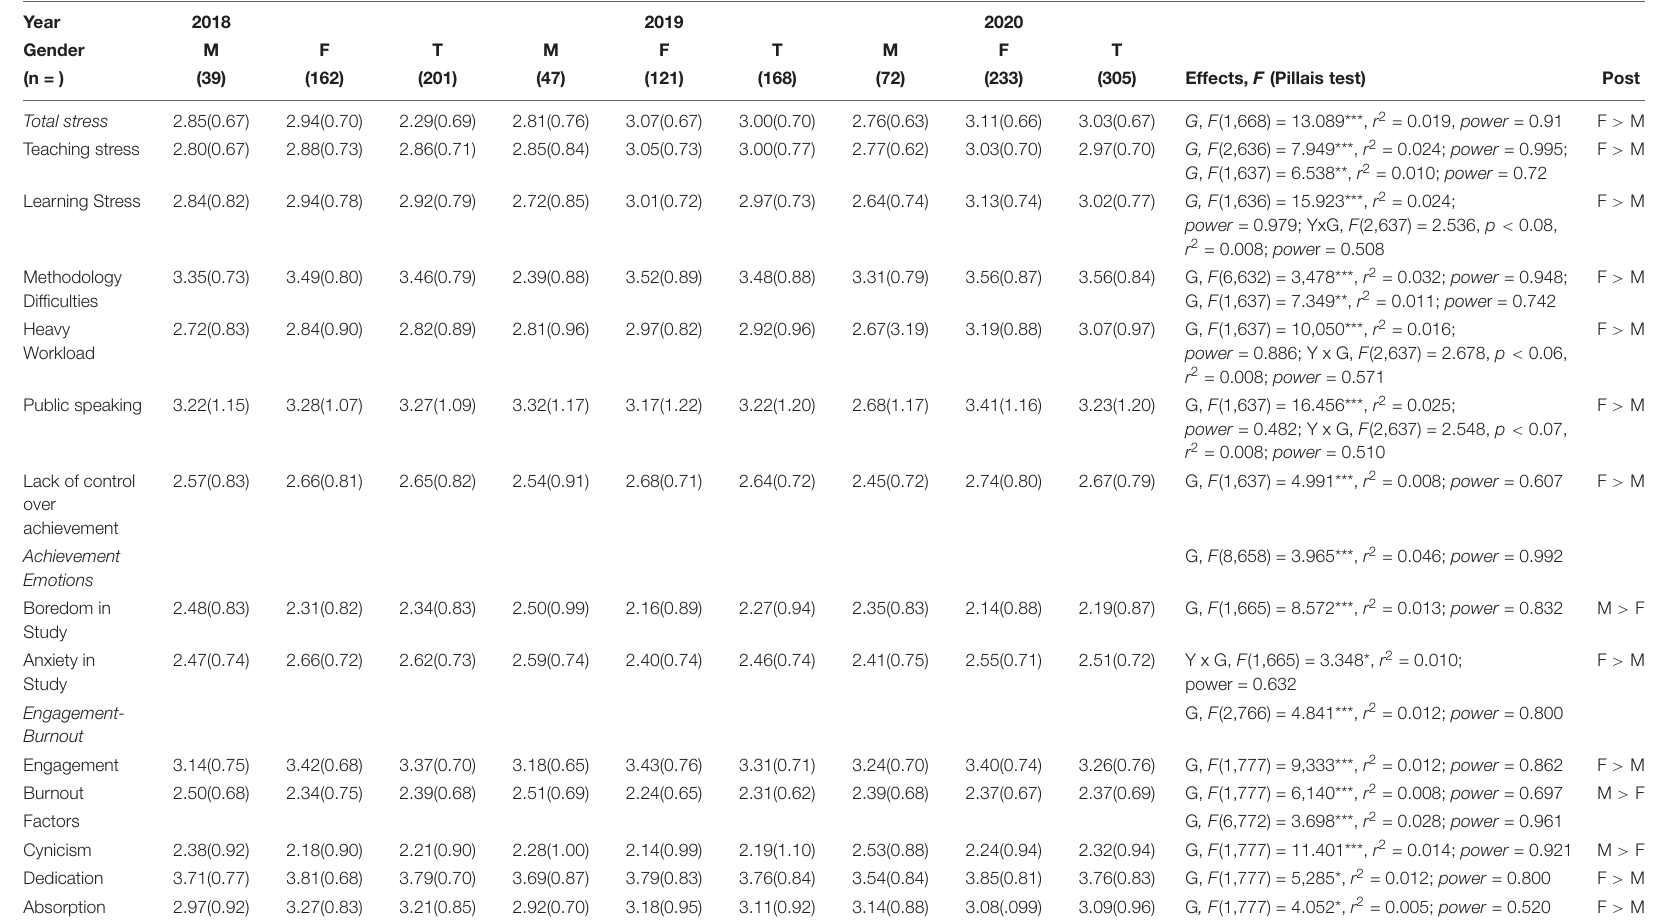
TABLE 4 | Descriptive values of the different levels of Stress Factors: M(SD) ( n =